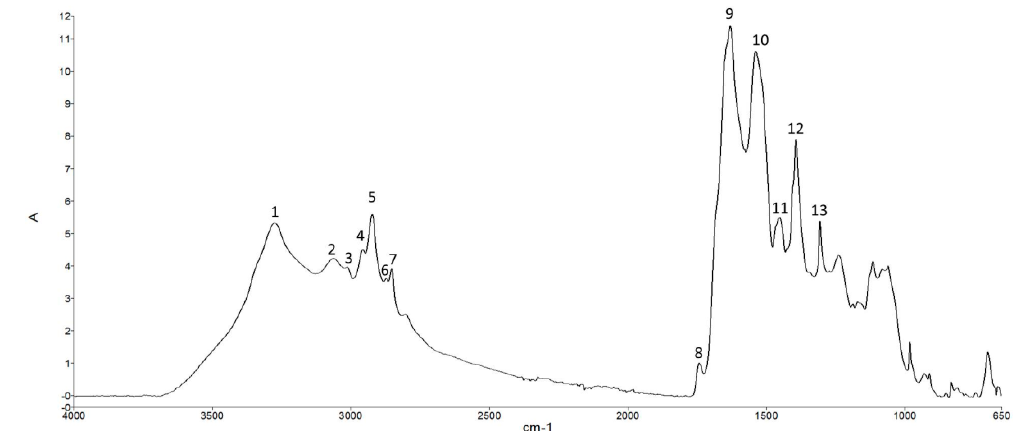
Figure 7. A typical ATR-FTIR absorption spectrum of the trout fillet in the 650–4000 cm − 1 . The spectrum was baseline corrected and normalized for the Amide I. The peak assignment is reported in Table 6.